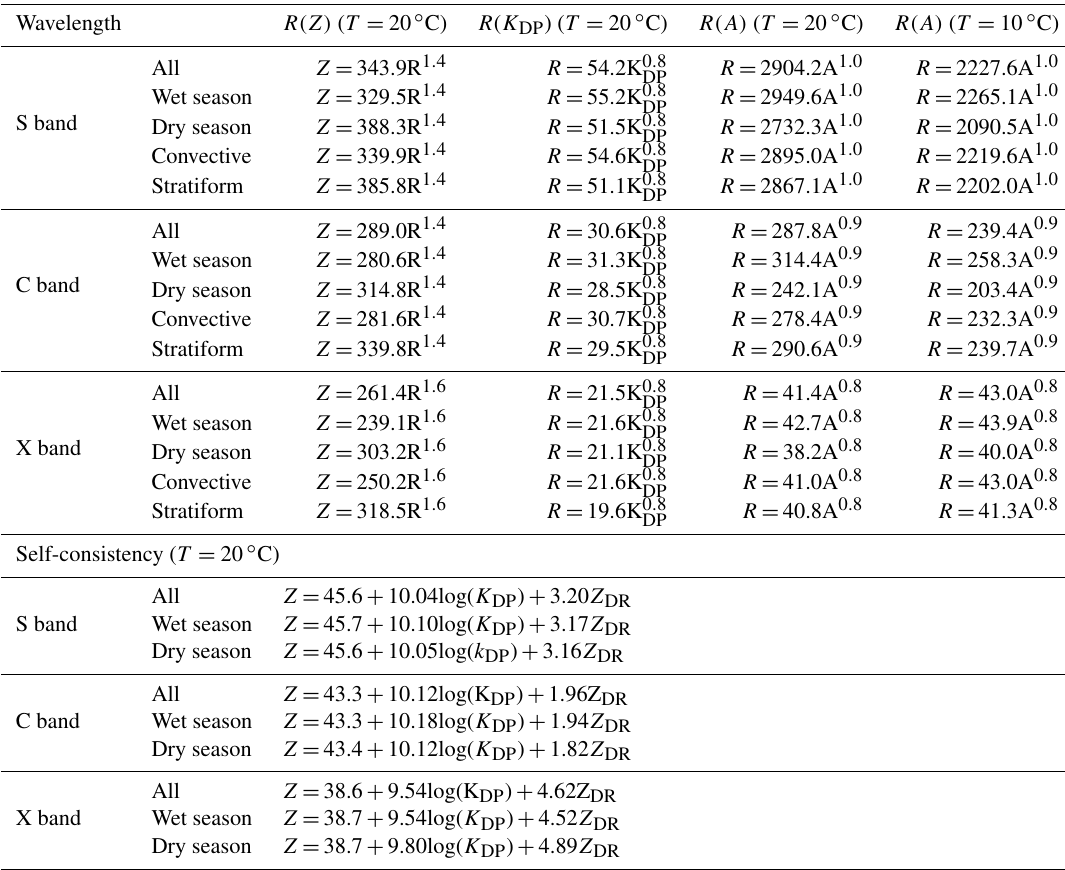
Table 2. Radar rainfall and self-consistency relations for the GoAmazon2014/5 dataset, for the cumulative dataset with all, wet and dry seasons, and convective and stratiform precipitation based on RWP classifications. Coefficients estimated at S-, C- and X-band radar wave-